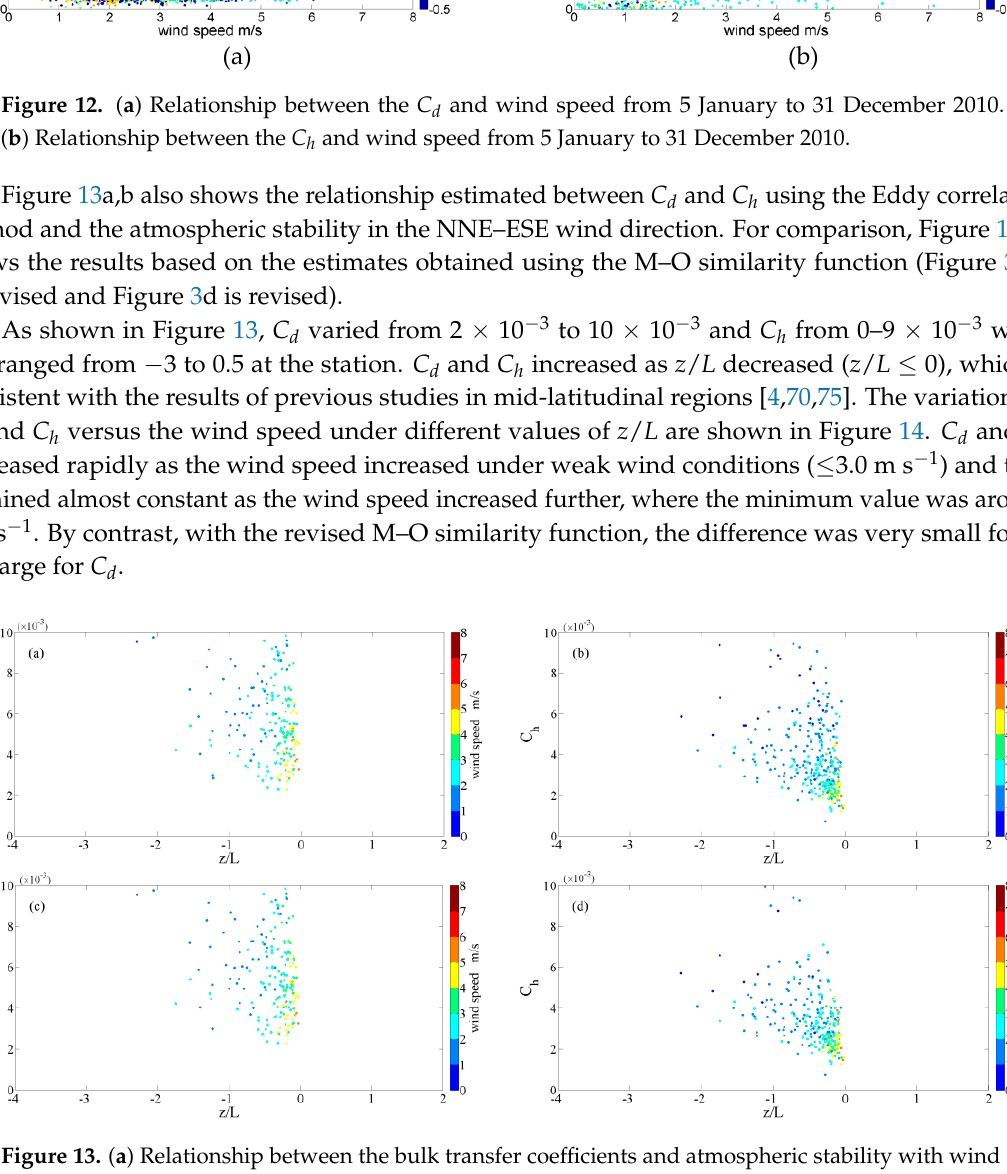
Figure 14. ( a ) Relationship between the bulk transfer coefficient C d and wind speed with wind directions of NNE–SES from 5 January to 31 December 2010. ( b ) Same as (a) but for C h . ( c ) Same as (a)